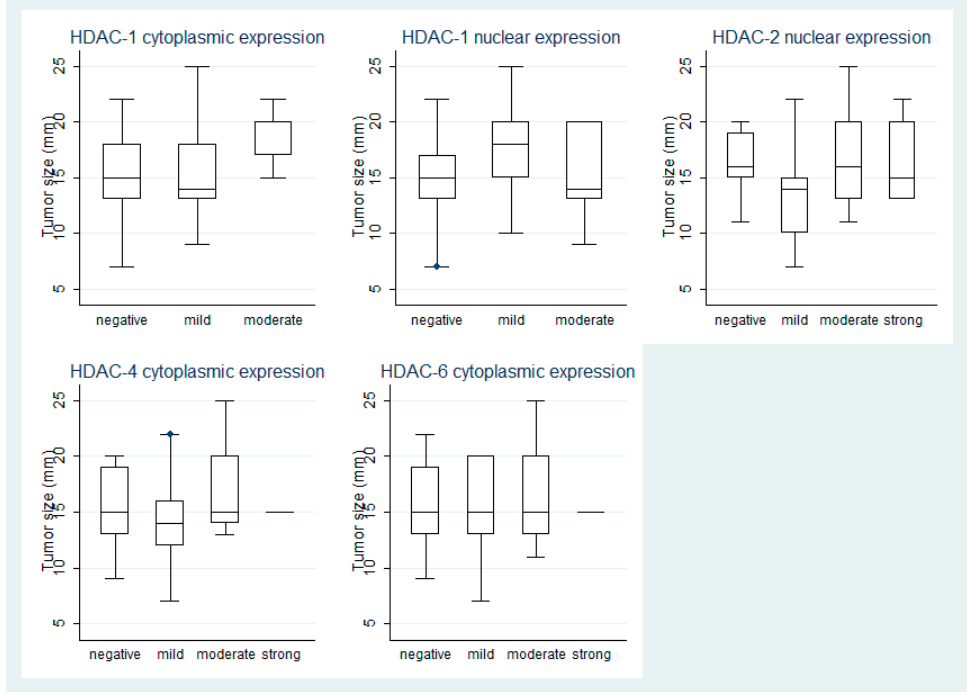
Figure 2. Schematic representation of the associations between HDAC-1, -2, -4, and -6 expression with tumor size. with tumor